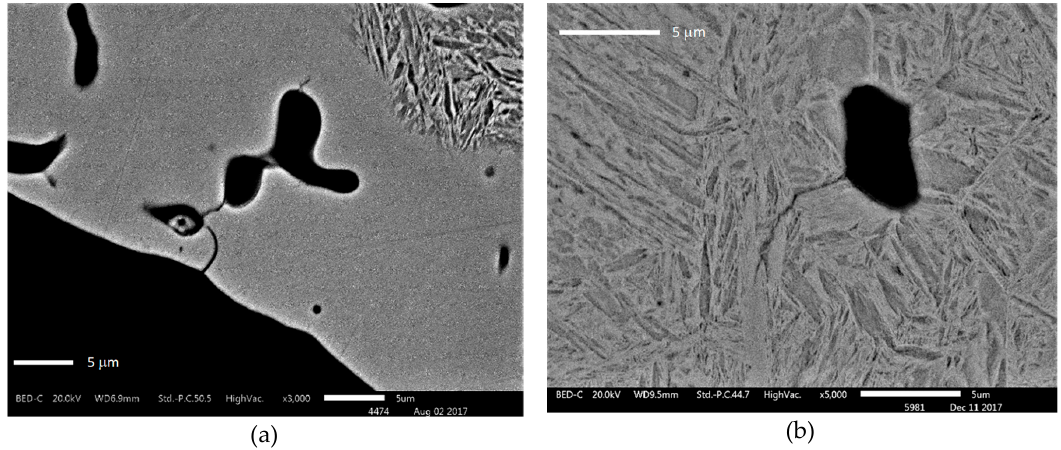
Figure 10. Non-propagating cracks found by SEM inspection in the DDH variant. ( a ) Cluster of pores interconnected by the crack, ( b ) single